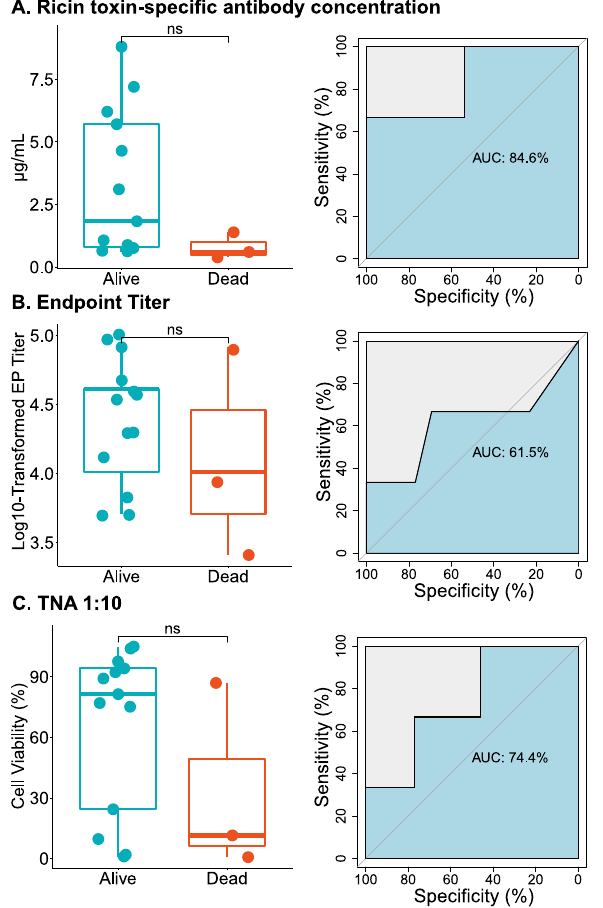
Fig. 4 Endpoint titer and toxin-neutralizing activity as potential correlates of protection against aerosolized RT exposure. Sera were collected from control and RiVax ® -vaccinated Rhesus macaques on study day 110 and then examined for A RT-speci fi c antibody concentrations, B RT-speci fi c endpoint titer, and C TNA 1:10 , as described in the “ Methods ” . Left panels ( A – C ): Levels of each analyte were compared between survivors and decedents with Mann – Whitey U tests (* p < 0.05), and results are shown in boxplots. Each point represents an individual macaque. The thick horizontal line in each box represents the median. The box de fi nes the 1 and 3 quartiles. The whiskers extend no more than 1.5 x interquartile range, with points beyond constituting outliers. Right panels ( A – C ): ROC curve analysis was performed to assess the predictive ability of each analyte, with speci fi city plotted against sensitivity. AUC values are shown for each curve in the center of the plots, with an AUC of 100% representing a perfect predictive